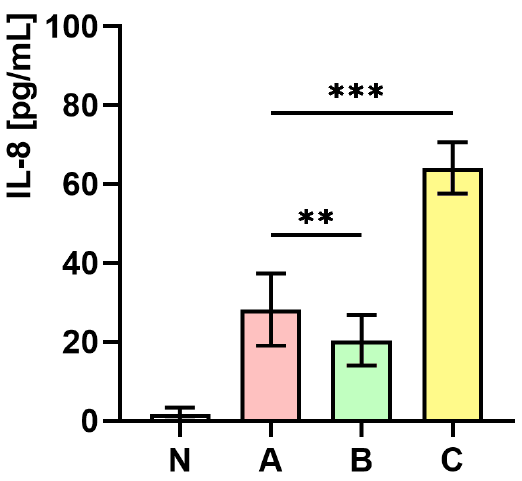
Figure 8. Measurements of IL-8 concentration in whole human blood non-infected (N) and infected with S. aureus Newman strain isolated from different modifications of the Mueller-Hinton agar: non-supplemented (control — medium A); supplemented with 1% ( v/v ) Tween 80 (medium B); supplemented with 1% ( v/v ) Tween 80 and trans -anethole at subinhibitory concentration — MIC 50 (medium C). Data are shown as the mean ± SD. ** p < 0.01, *** p < 0.001.